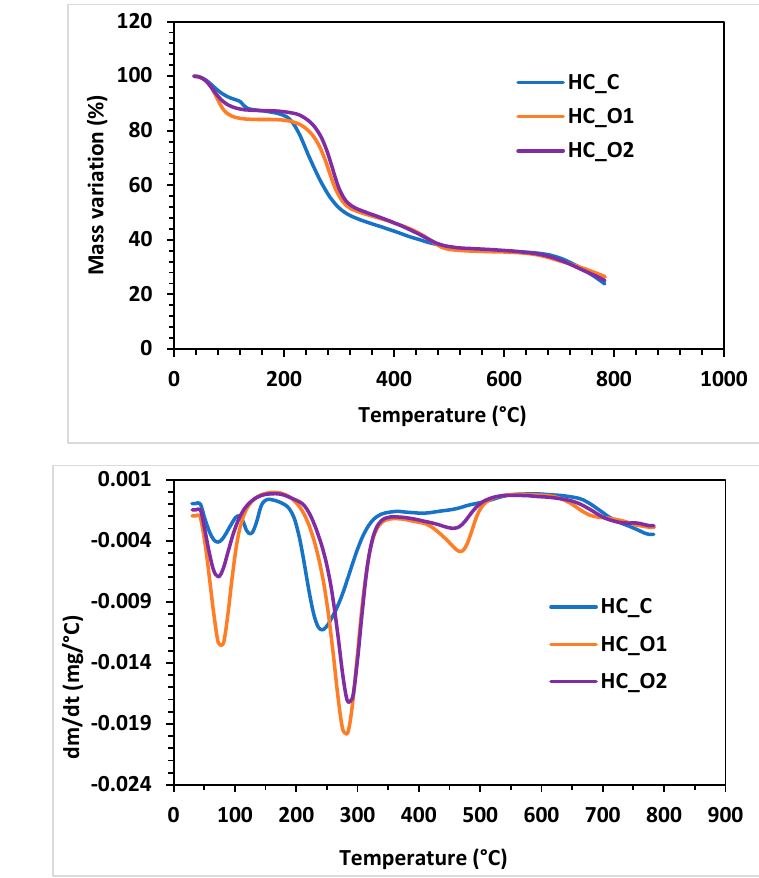
Figure 8. Thermogravimetric analysis: ( a ) mass-variation curves; ( b ) DTG curves. The second stage of the thermo-gravimetric test corresponds to the polymeric chain degradation phase. For the HC_C sample, this occurs between 215 ◦ C and 295 ◦ C, with a mass loss of ~41% and a peak at 234 ◦ C. HC_O1 and HC_O2 showed a degradation phase occurring in similar temperature ranges: (i) 248–303 ◦ C for HC_O1 with a DTG peak observed at 283 ◦ C, 37.6% mass loss; and (ii) 258–309 ◦ C for HC_O2 with a peak at 290 ◦ C and 39.3% mass loss. The higher temperatures of corresponding HC_O1 and HC_O2 peaks during the second stage compared with HC_C indicate their better thermal